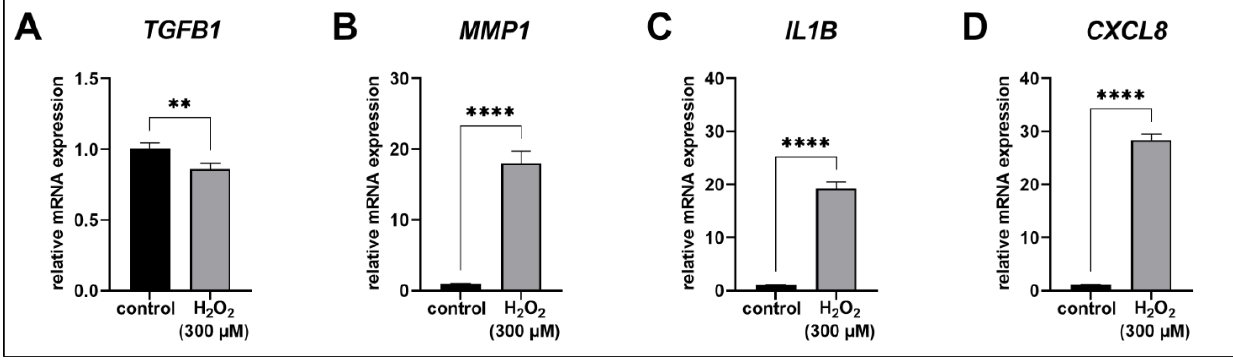
Figure 4. Expression analysis of the SASP in acute senescent proto-myofibroblasts. After 24 h of cultivation, cells were treated for 1 h with 300 µM H 2 O 2 or H 2 O (control). Relative TGFB1 ( A ), MMP1 ( B ), IL1B ( C ) and CXCL8 ( D ) mRNA expression levels were determined after 72 h of cultivation by quantitative real-time PCR and were normalized on GAPDH mRNA expression level. Values shown are means ± SEM for three biological and three technical replicates per experiment and were calculated relative to the respective control. Mann-Whitney U test: p < 0.01 (**) and p < 0.0001 (****).